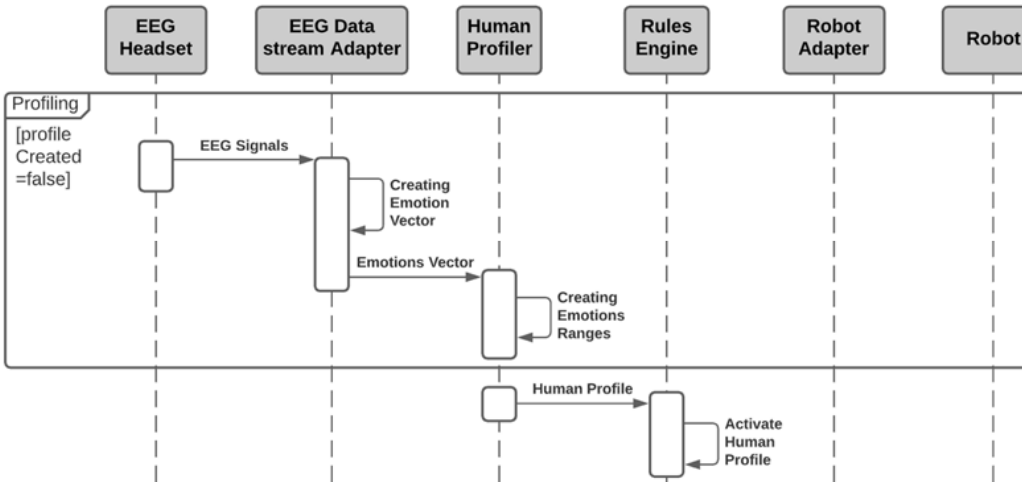
Figure 2. System architecture for human emotion ‐ driven robot configurator.